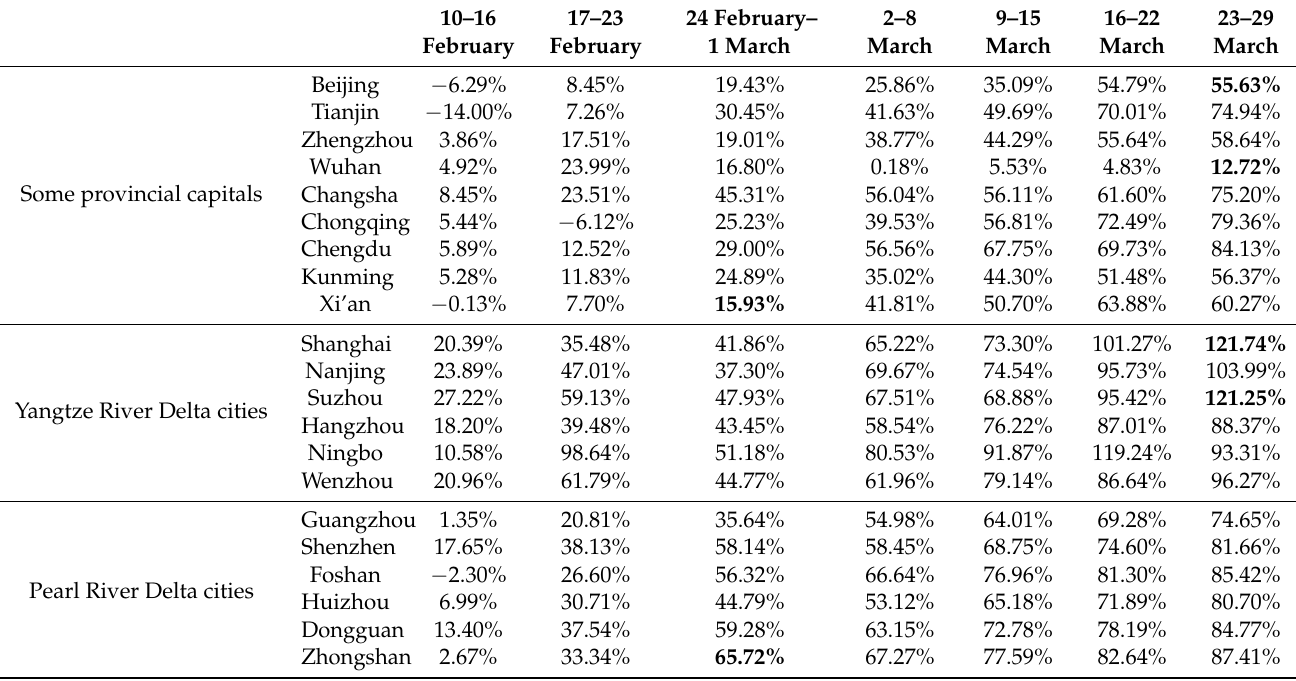
Table 1. Average work resumption indexes of 21